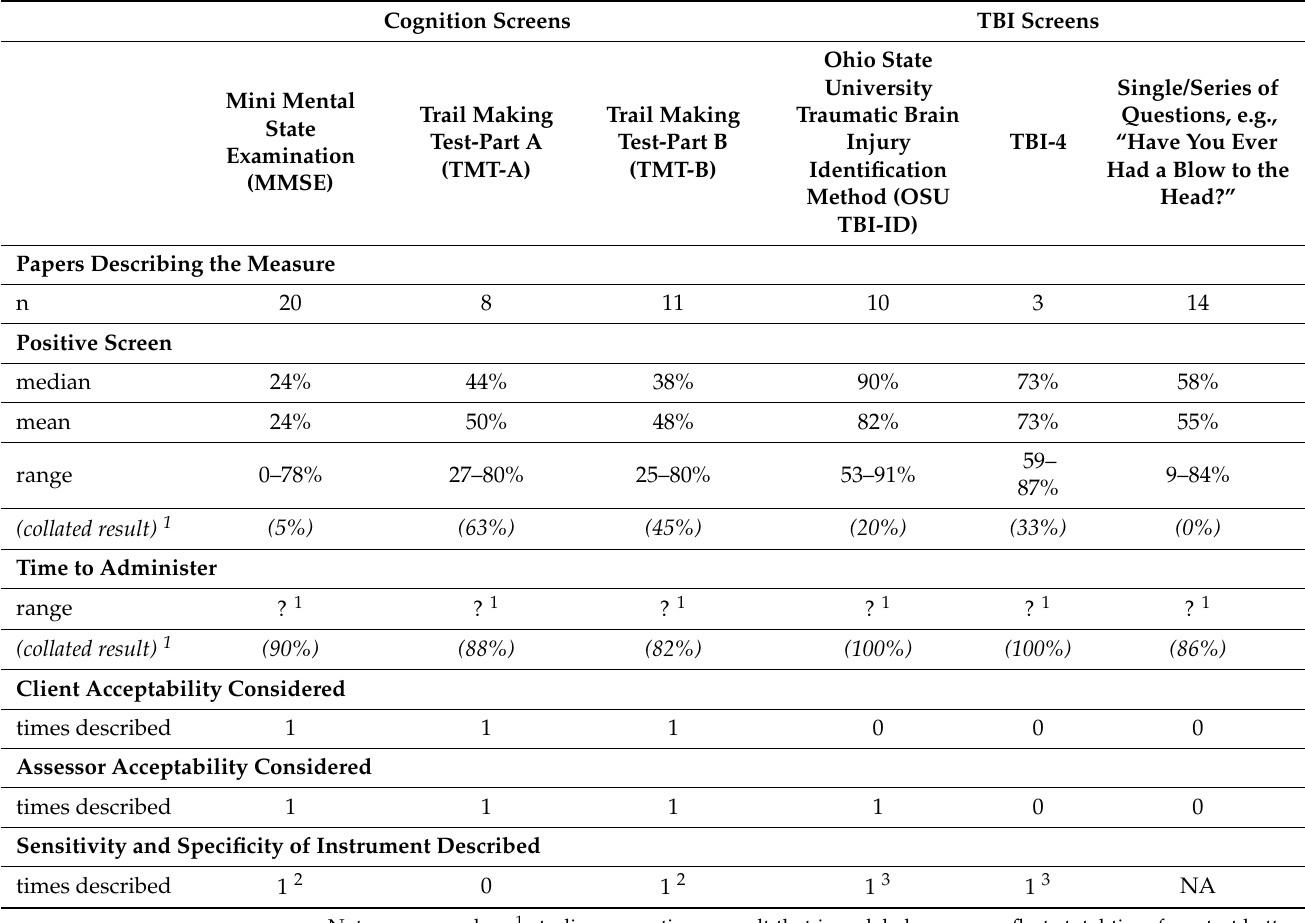
Table 4. Key features of unrestricted